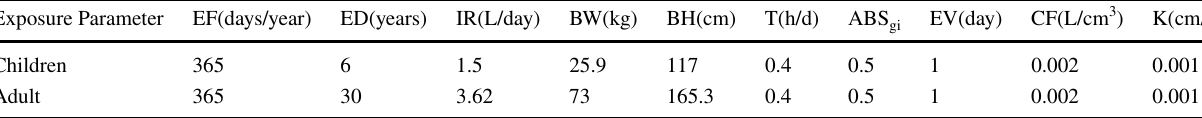
Table 1 Exposure parameters of human health risk assessment in different groups Exposure